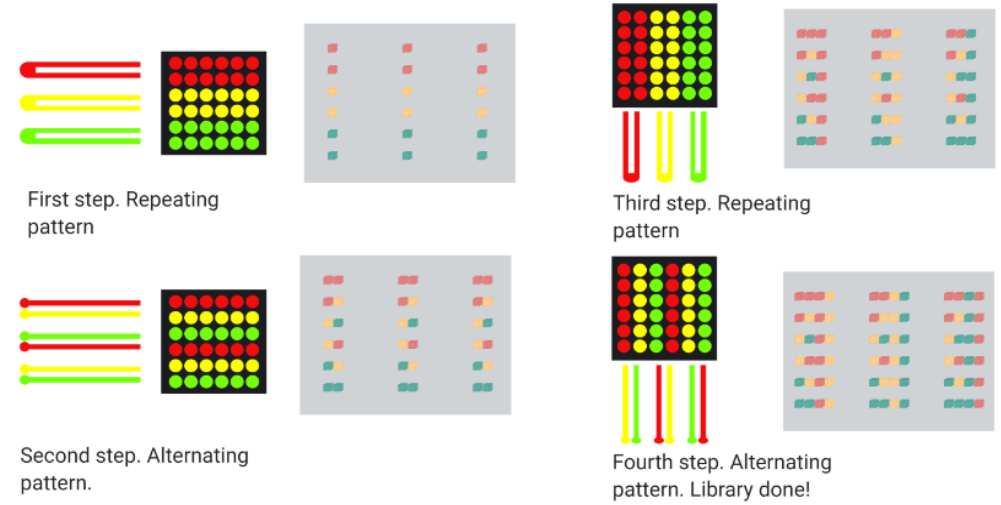
Figure 9. Schematic of combinatory microarray screening performance used by Zhao where possible permutations of the combinatorial peptide library are obtained using different combinatorial flow patterns of amino acids applied to a blank microdisk array. (Created with BioRender).